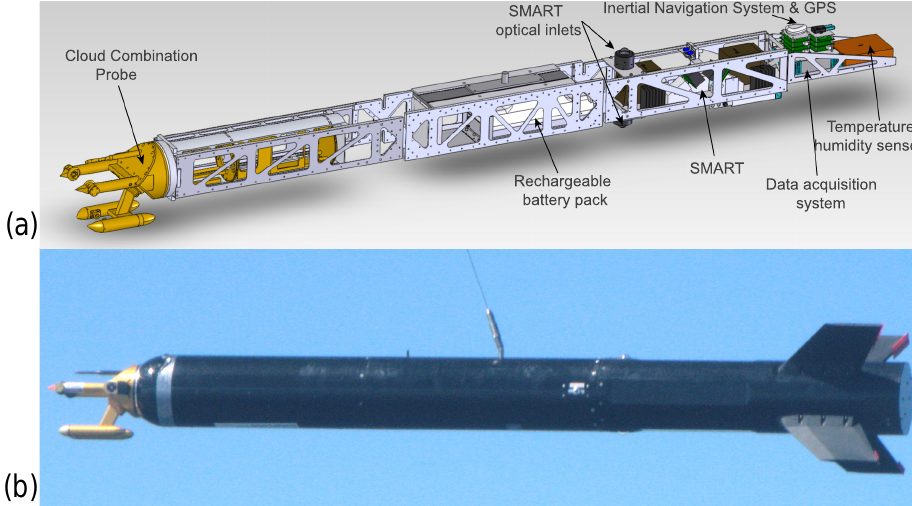
Figure 2. Different states of the AIRTOSS development process. Panel (a) shows a perspective view of the position of the instruments (Röschenthaler, 2013), including the Spectral Modular Airborne Radiation measurement sysTem (SMART). Panel (b) shows the manufac- tured AIRTOSS during a